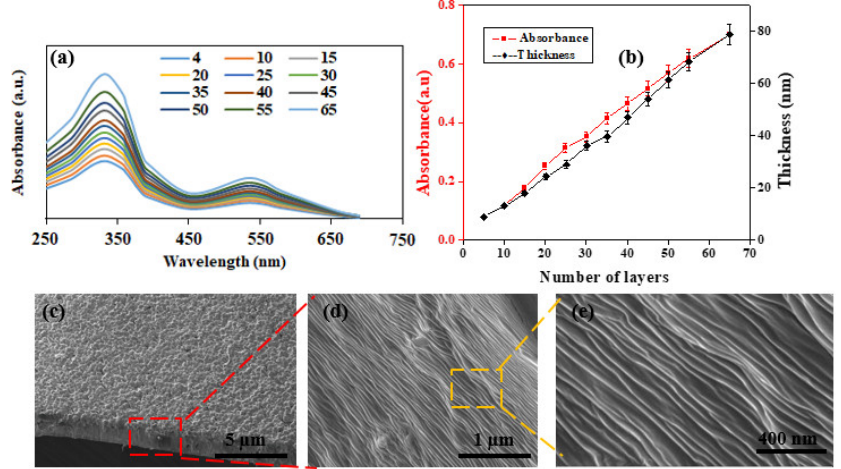
Figure 1. ( a ) UV-vis spectra of AN-PEEK/f-CNOs LbL films as a function of the number of layers. ( b ) Absorbance at 340 nm as a function of the number of layers and thickness of AN-PEEK/f-CNOs thin films measured by profilometry. ( c ) Cross-sectional, and ( d , e ) side-view of the SEM images of AN-PEEK / f-CNOs nanocomposite thin film with 5 wt% of f-CNOs.